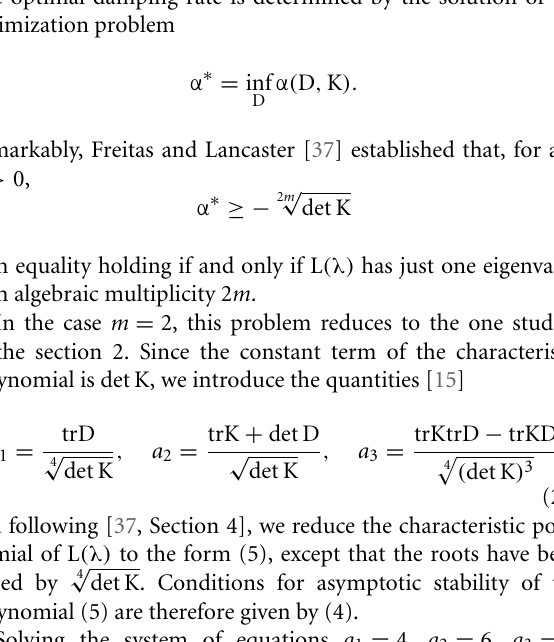
√ √ 3 = 4 3 and 3 when a 1